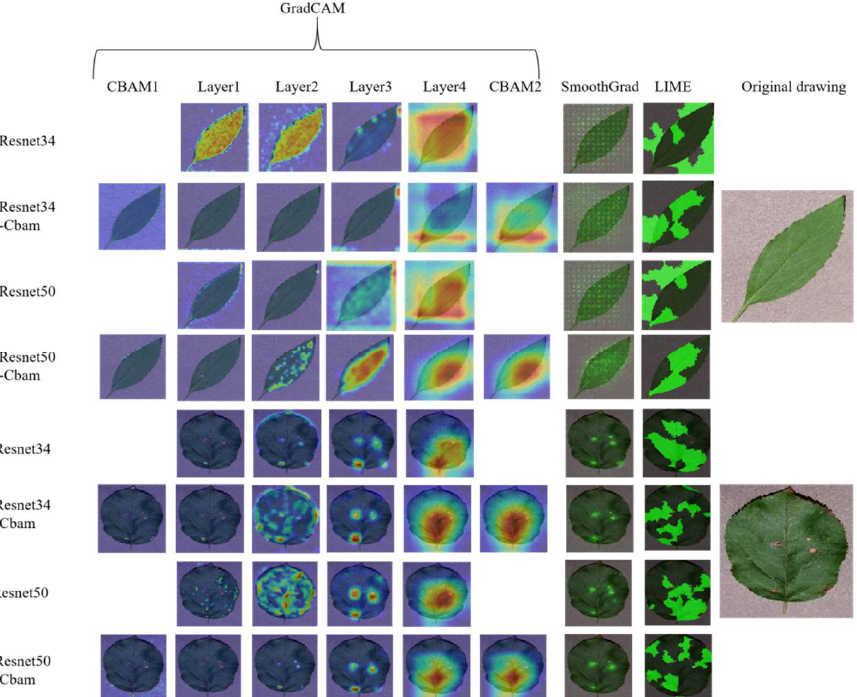
Figure 7. Leaf background and shadow results based on Experiment II. Each row represents the visualization result diagram of a model, and each column represents the effect diagram of Grad- CAM (including CBAM1, Layer1–4, and CBAM2 each layer result diagram. Layer1–4 corresponds to the four convolutional layers of random ResBlock in Figure 3), SmoothGrad, LIME, and the original image.